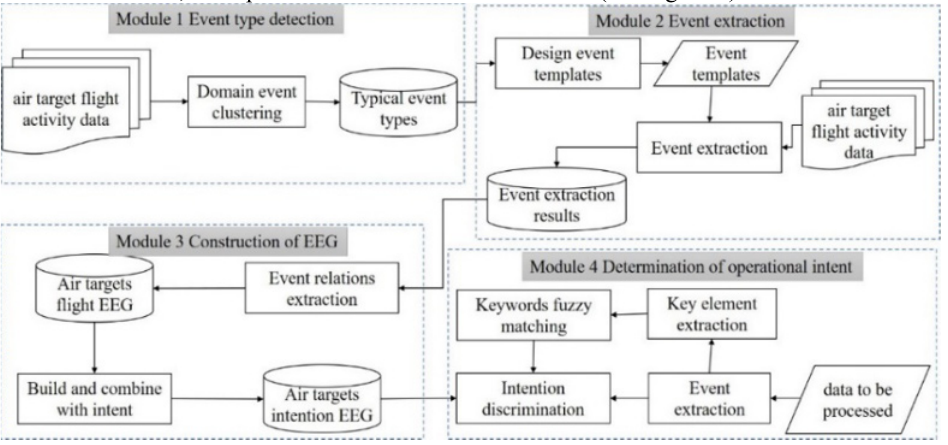
Fig. 1. Target intent determination of event evolutionary knowledge